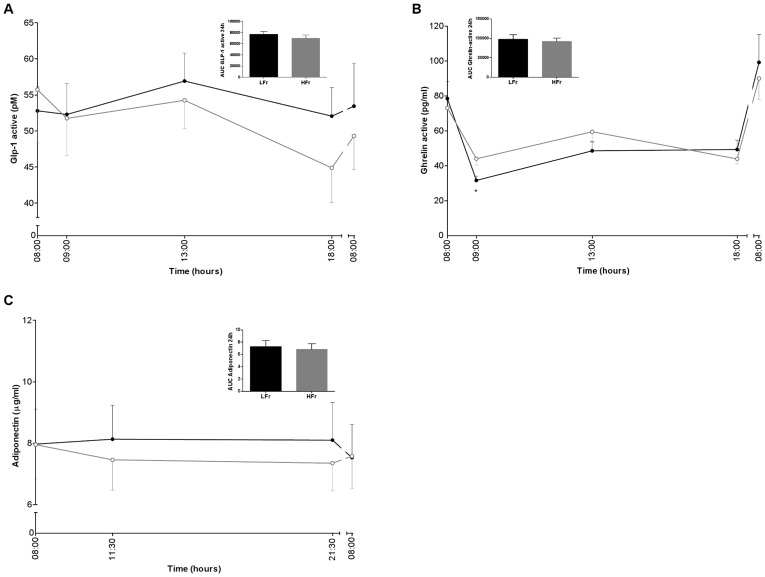
GLP-1 active (A), ghrelin-active (B) and adiponectin (C) levels for 24 h and the AUCs of the LFr (dense black circle ) and HFr (open gray circle ) diet.*P<0.05 LFr vs. HFr diet. P-values were derived by analysis of mixed models for the 24 h profiles and by a paired t-test for the AUCs. aValues are expressed as mean±SEM.